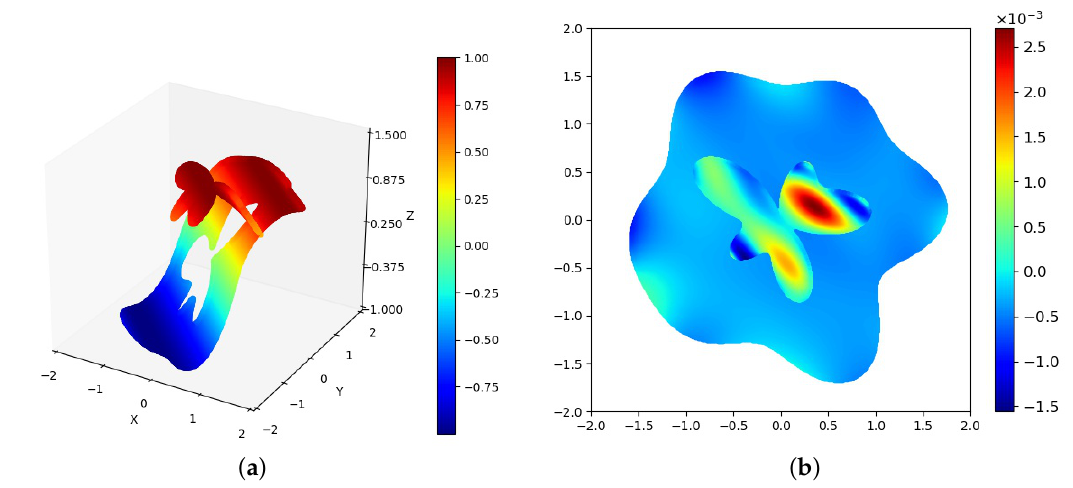
Figure 12. ( a ) The PINN solution and ( b ) the error between PINN and the exact solution for Example 4.